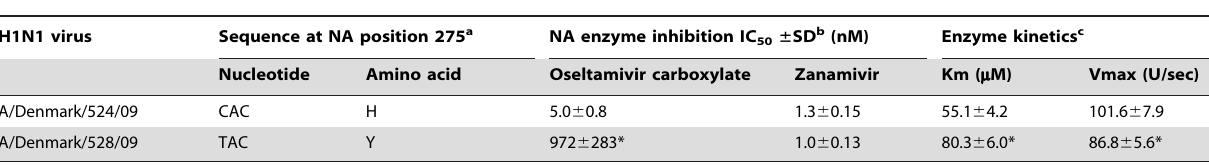
Table 1. Neuraminidase enzymatic properties of the H1N1 influenza viruses.